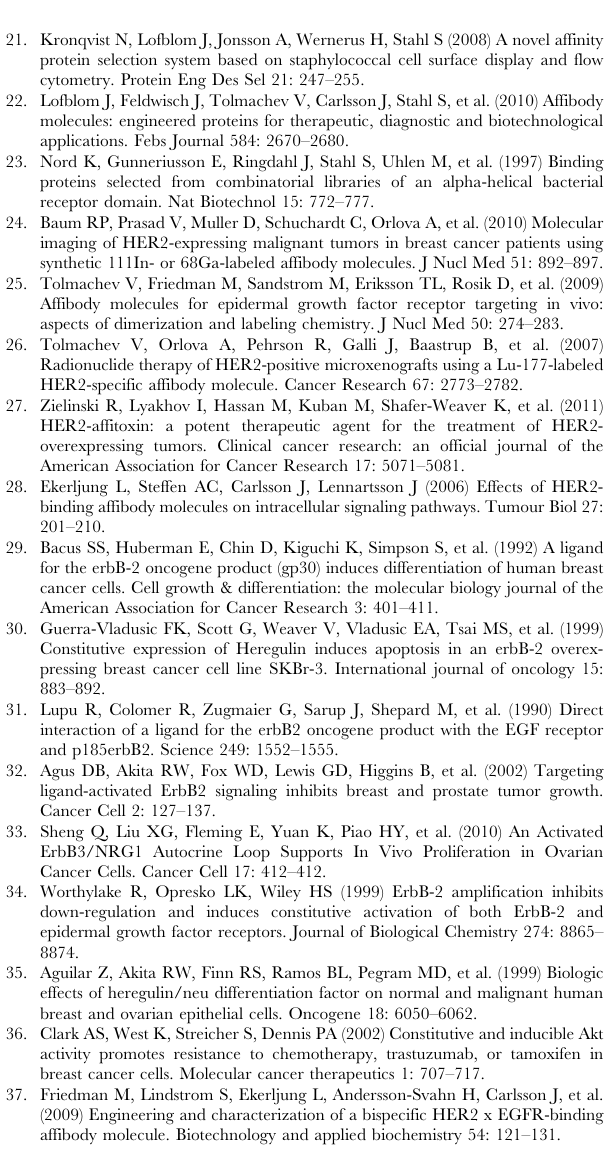
Figure S1 Analysis of SKBR-3 cell proliferation in presence of HRG. Mean absorbance values at 450 nm 6 SD, which is proportional to the number of living cells, is given on the y-axis. Proliferation of SKBR-3 cells grown in a dilution series of HRG. The bell-shaped curve demonstrates a biphasic effect of HRG on cell growth in a concentration dependent